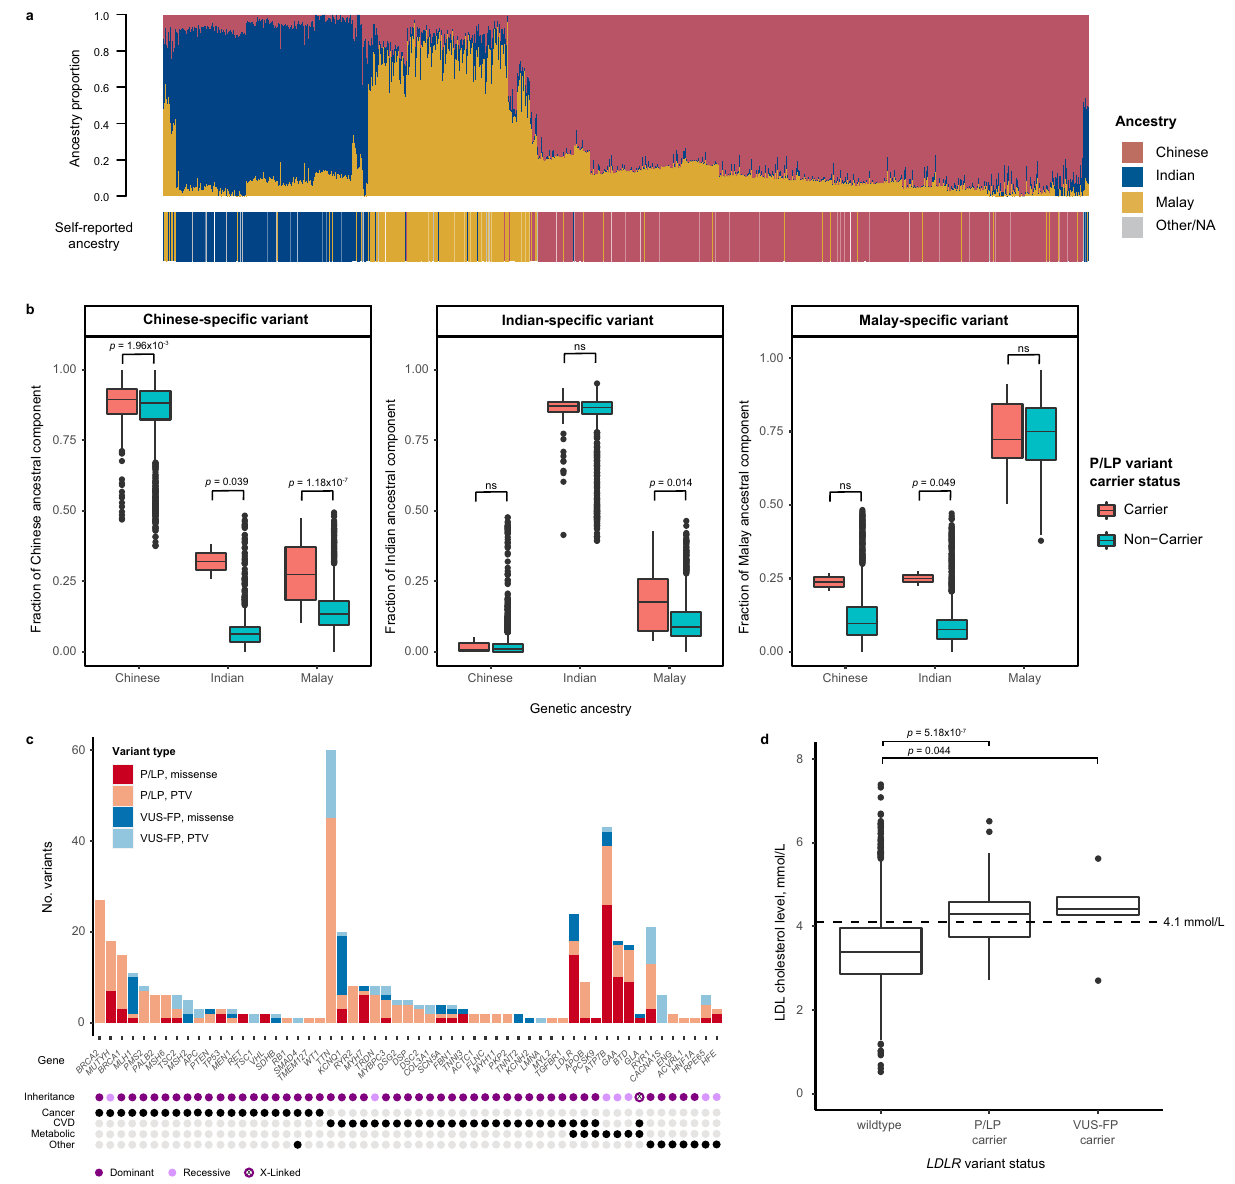
Fig. 2 | Evaluating the in fl uence of genetic admixture and potentially patho- genic VUS in SG10K_Health cohort. a ADMIXTURE analysis of inferred genetic ancestral components atK=3 juxtaposed with self-reported ancestryfor the 9,051 Singaporean individuals. NA: not available. b The proportion of genetic ancestral components tracked consistently with carrier status of pathogenic/likely patho- genic (P/LP) variants speci fi c to the associated ancestry group across Singaporean Chinese (CH), Indian (IND) and Malay (MY) individuals (Chinese-speci fi c variant carriers/non-carriers: (CH) 455/5047, (IND) 2/1939, (MY) 26/1582; Indian-speci fi c variant carriers/non-carriers: (CH) 3/5499, (IND) 147/1794, (MY) 19/1589; Malay- speci fi c variant carriers/non-carriers: (CH) 2/5500, (IND) 2/1939, (MY) 24/1584). Pairwisedifferencesbetweencarriersandnon-carrierswereevaluatedbytwo-sided Wilcoxon rank-sum test. p <0.05 was considered signi fi cant. ns: not signi fi cant. c Juxtaposition of P/LP variants with potentially pathogenic variants of uncertain signi fi cance(missenseandcrypticsplicevariants)classi fi edasVUS-FP,identi fi edin